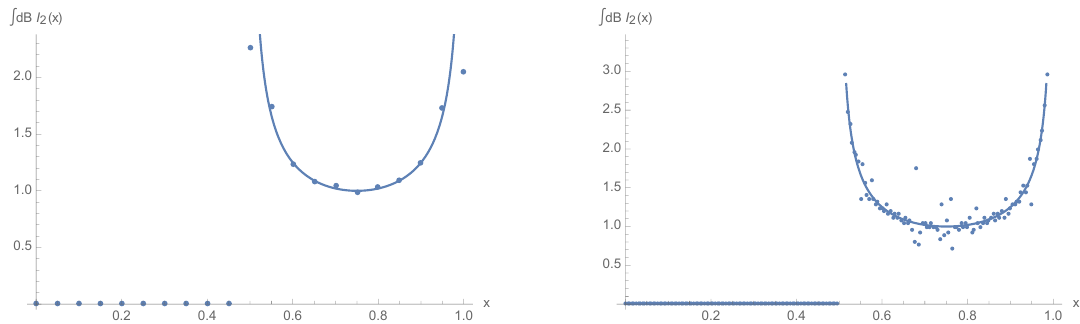
Figure 2 . The prediction for the distribution of values of x = ( q 4 + r 4 ) = ( q 2 + r 2 ) 2 compared with numerical values for all ( q; r ) with q 2 + r 2 (cid:20) 10 000, where numerical values are averaged over bins of size 1 = 20 (left) and 1 = 200 (right). Irregularities in the right diagram indicate number-theoretical p patterns that become relevant for bins smaller than 1 = B , such as the large peak at x = 0 : 68, as mentioned in the